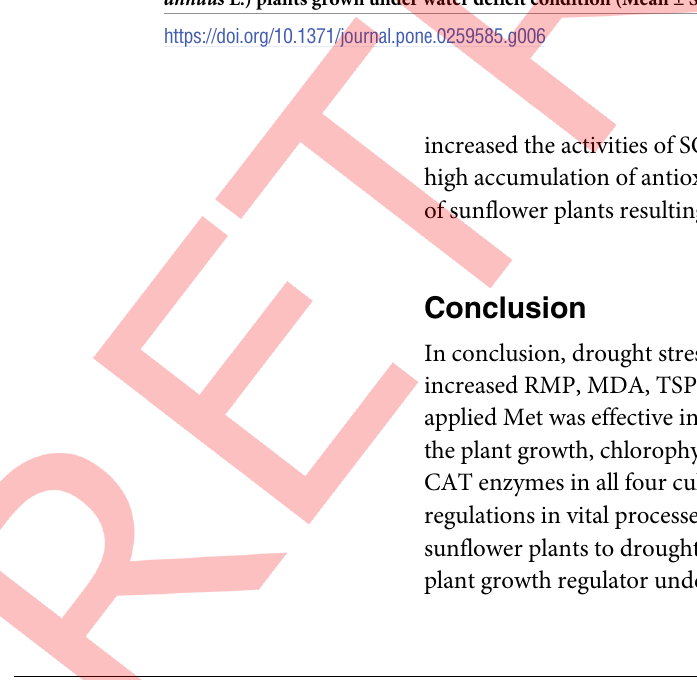
Fig 6. Effect of foliarly applied L-methionine on activity of antioxidant enzymes (A) SOD, (B) POD and (C) CAT in sunflower ( Helianthus annuus L.) plants grown under water deficit condition (Mean ±